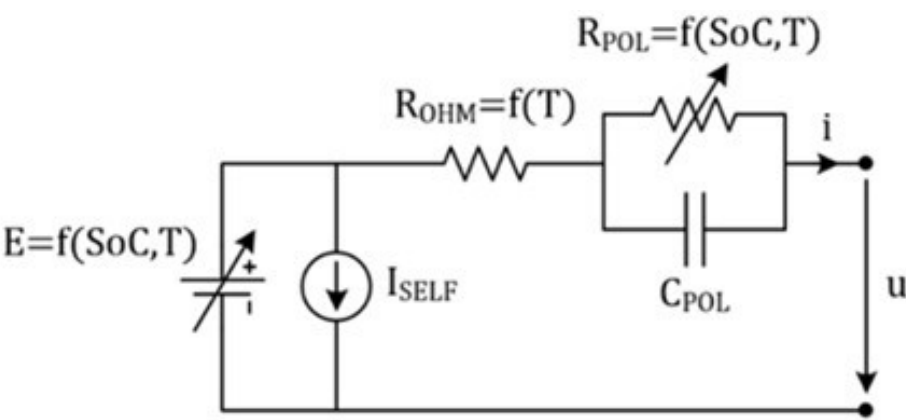
Figure 6. Battery equivalent circuit